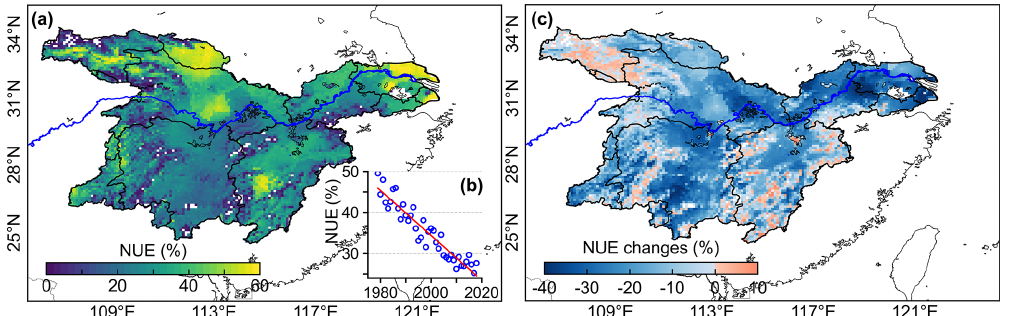
Figure 4. Nitrogen use efficiency (NUE) on the Yangtze Plain from 1979–2018. (a) Spatial distributions of climatological NUE (1979–2018). The inset (b) shows the long-term trends of the area mean NUE. (c) Changes in NUE between the first (1979–1988) and the last (2009–2018) decades.